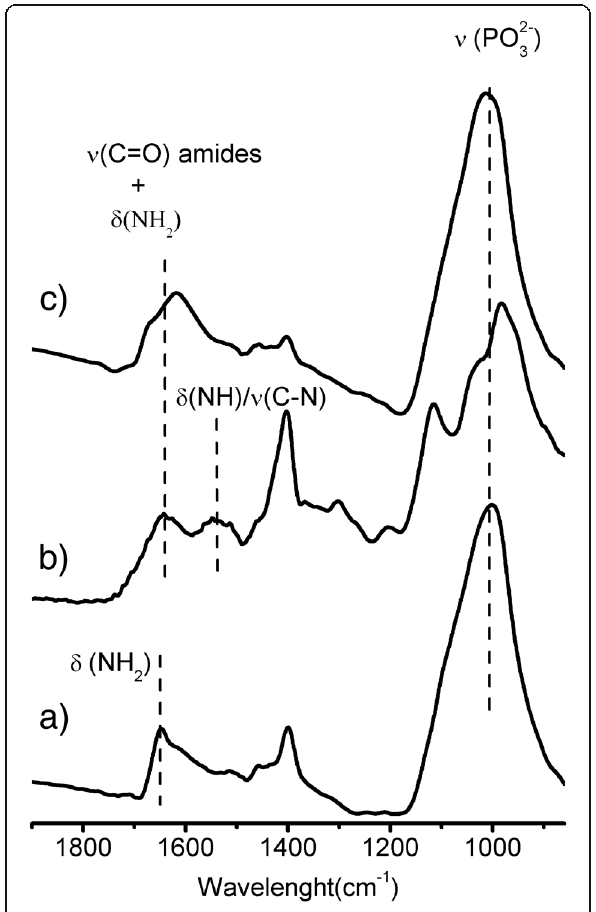
Fig. 4 FT-IR characterization of functionalized MNPs. FT-IR spectral region in the 850 – 1900 cm − 1 range of a) NH 2 @MNPs, b) gH625@MNPs, and c)